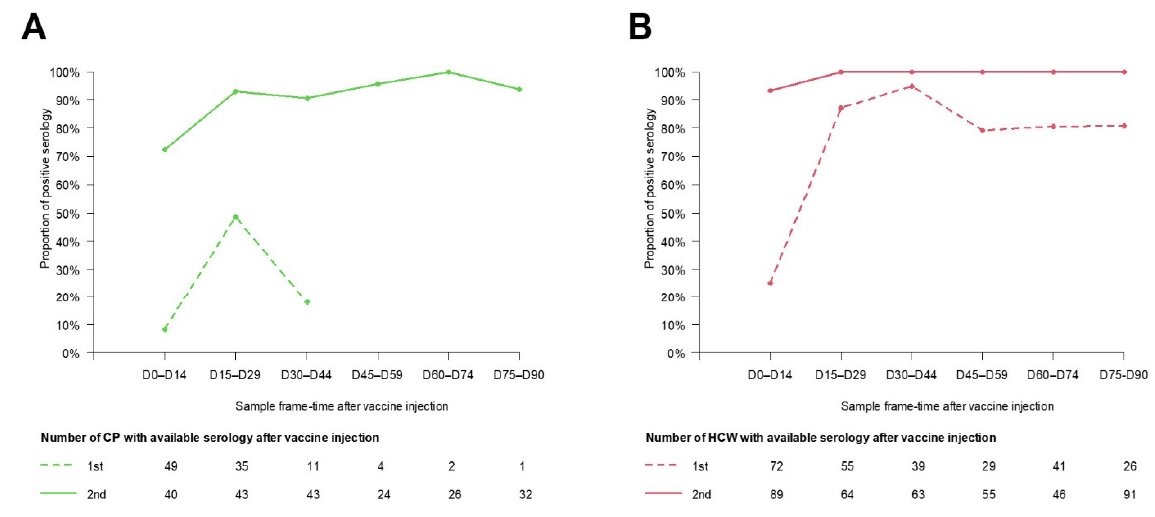
Figure 2. Proportion of CP ( A ) and HCW ( B ) with seroconversion in per-two-weeks after vaccination.